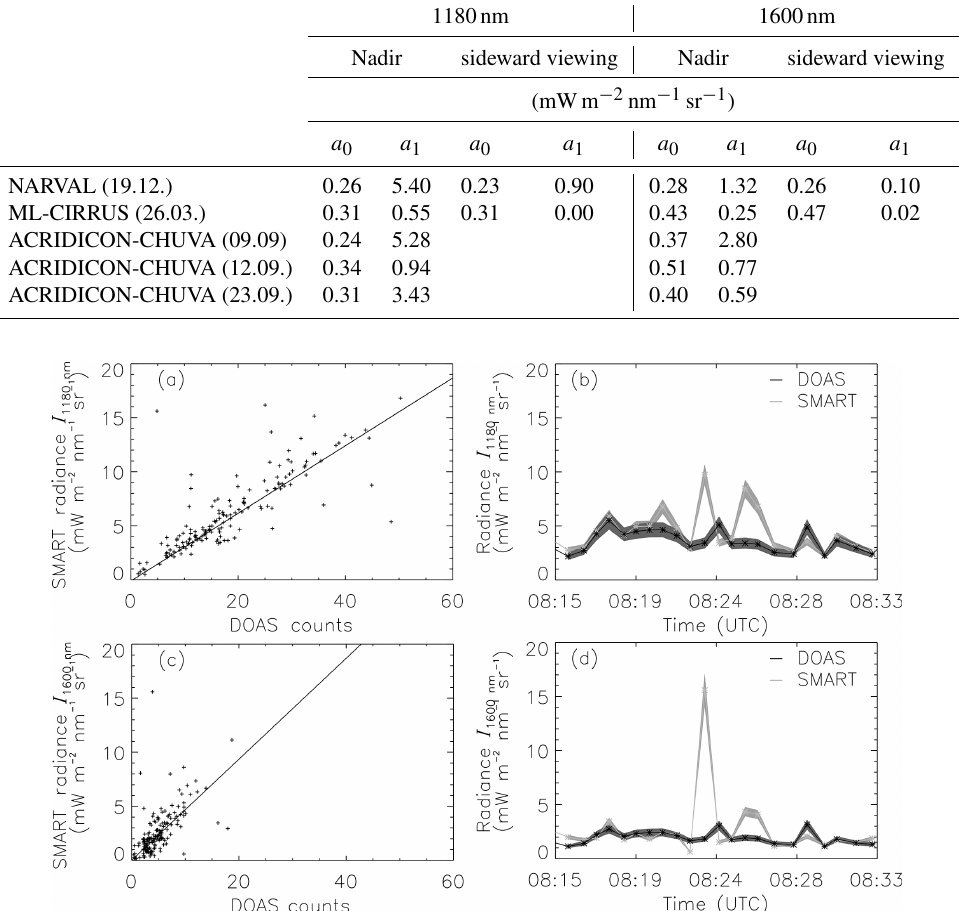
Figure 9. Panels (a) and (c) show a comparison of SMART radiance I N λ = 1180nm and λ = 1600nm wavelength. Panels (b) and (d) show time series of measured SMART radiance I N DOAS radiance I V for the ML-CIRRUS flight on 26 March 2014. The shaded areas indicate the measurement mD ,λ